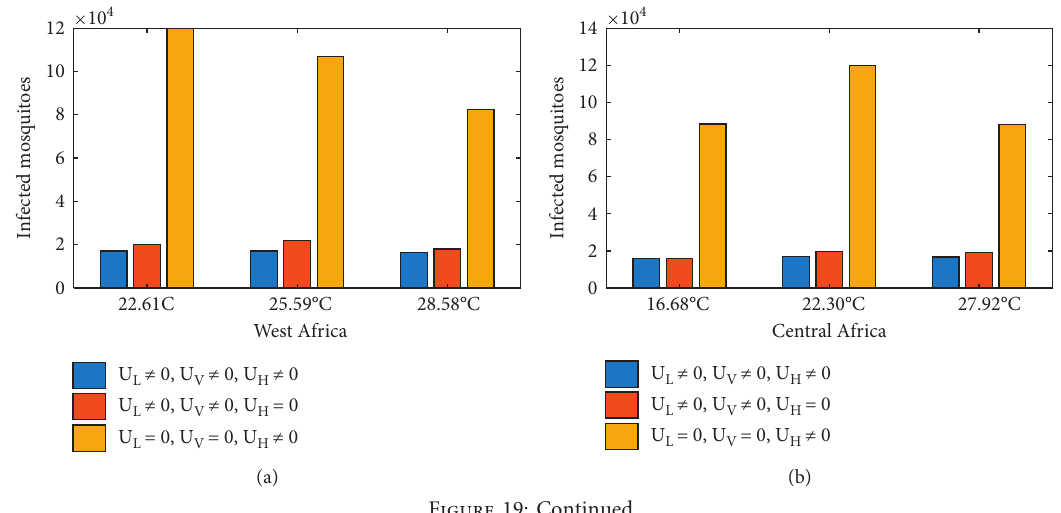
Figure 18: Simulations of the malaria-resistant model (21) as a function of time plotting the average control levels for controls u u H in West, Central, East, Central, and South